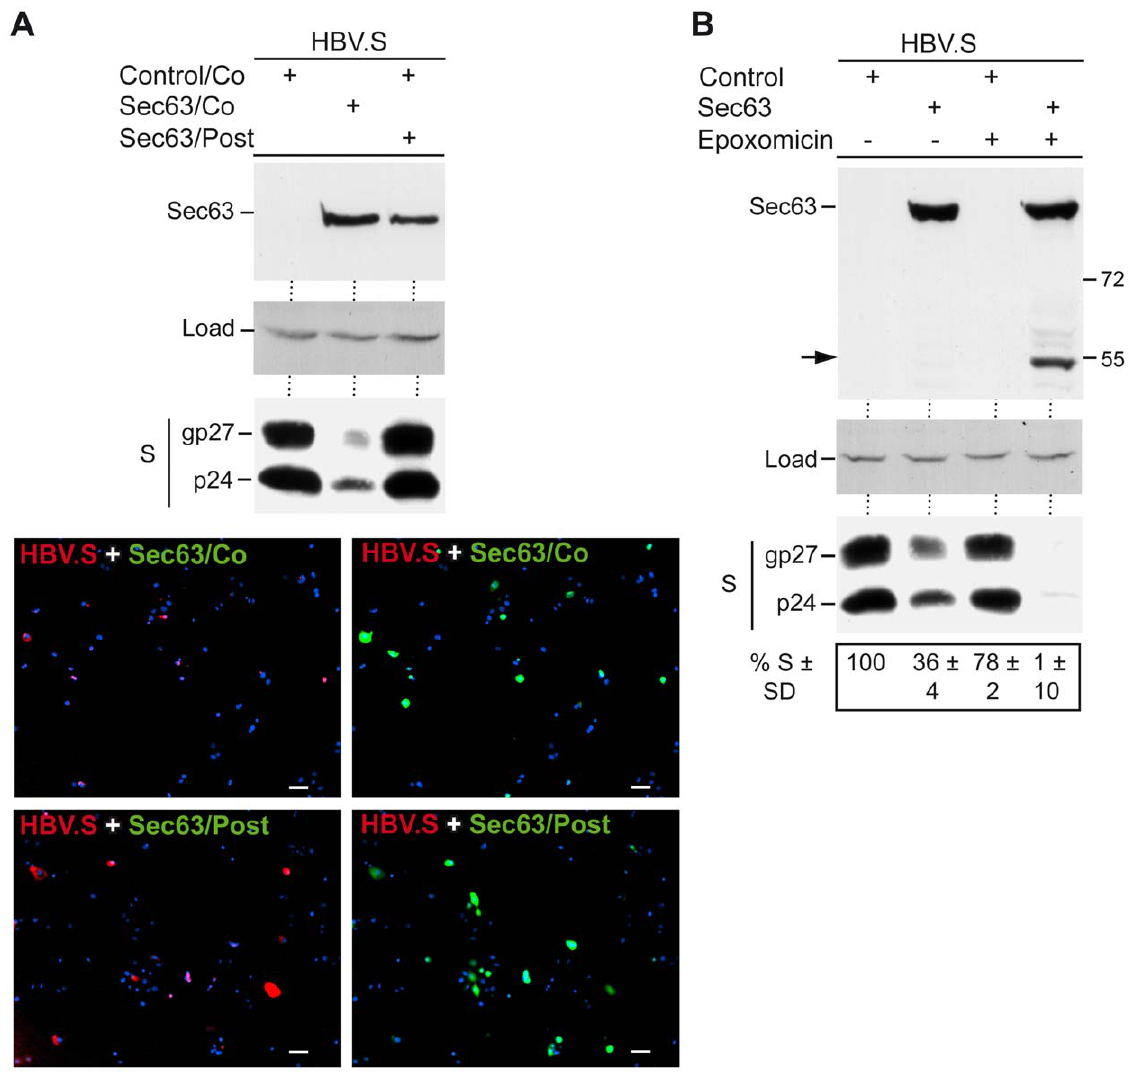
Figure 4. Overexpressing of Sec63 acts during HBV.S formation in a proteasome-independent manner. A. HBV.S was transfected with control DNA or Myc-tagged Sec63 at a 1:3 ratio, respectively, either simultaneously (Control/Co and Sec63/Co) or postponed (Sec63/Post). In the latter case, cells transfected with HBV.S were retransfected with Sec63 two days later and harvested after additional 24 h. Cell lysates were probed by anti-Myc (top) and anti-HA (middle bottom) WB. Uniformity of sample loading is shown by a band cross-reacting with the HA antibody (load). Immunofluorescence analysis of HBV.S + Sec63/Co- and HBV.S + Sec63/Post-transfected cells. Representative pictures are shown in the bottom. Cells were stained with mouse anti-Myc and rat anti-HA antibodies followed by staining with AlexaFluor 488-conjugated anti-mouse and AlexaFluor 546- conjugated anti-rat antibodies. DNA staining of the nuclei is in blue. Bar, 50 m m. B. For proteasomal inhibition, cells were cotransfected with HBV.S plus control DNA or Myc-tagged Sec63 and were mock-treated or treated with epoxomicin for 16 h. Cell lysates were analyzed as in A. The arrow to the left of the top panel depicts degradation products of Sec63. HBV.S levels are demonstrated in percent amount 6 SD relative to control cells ( n =3).